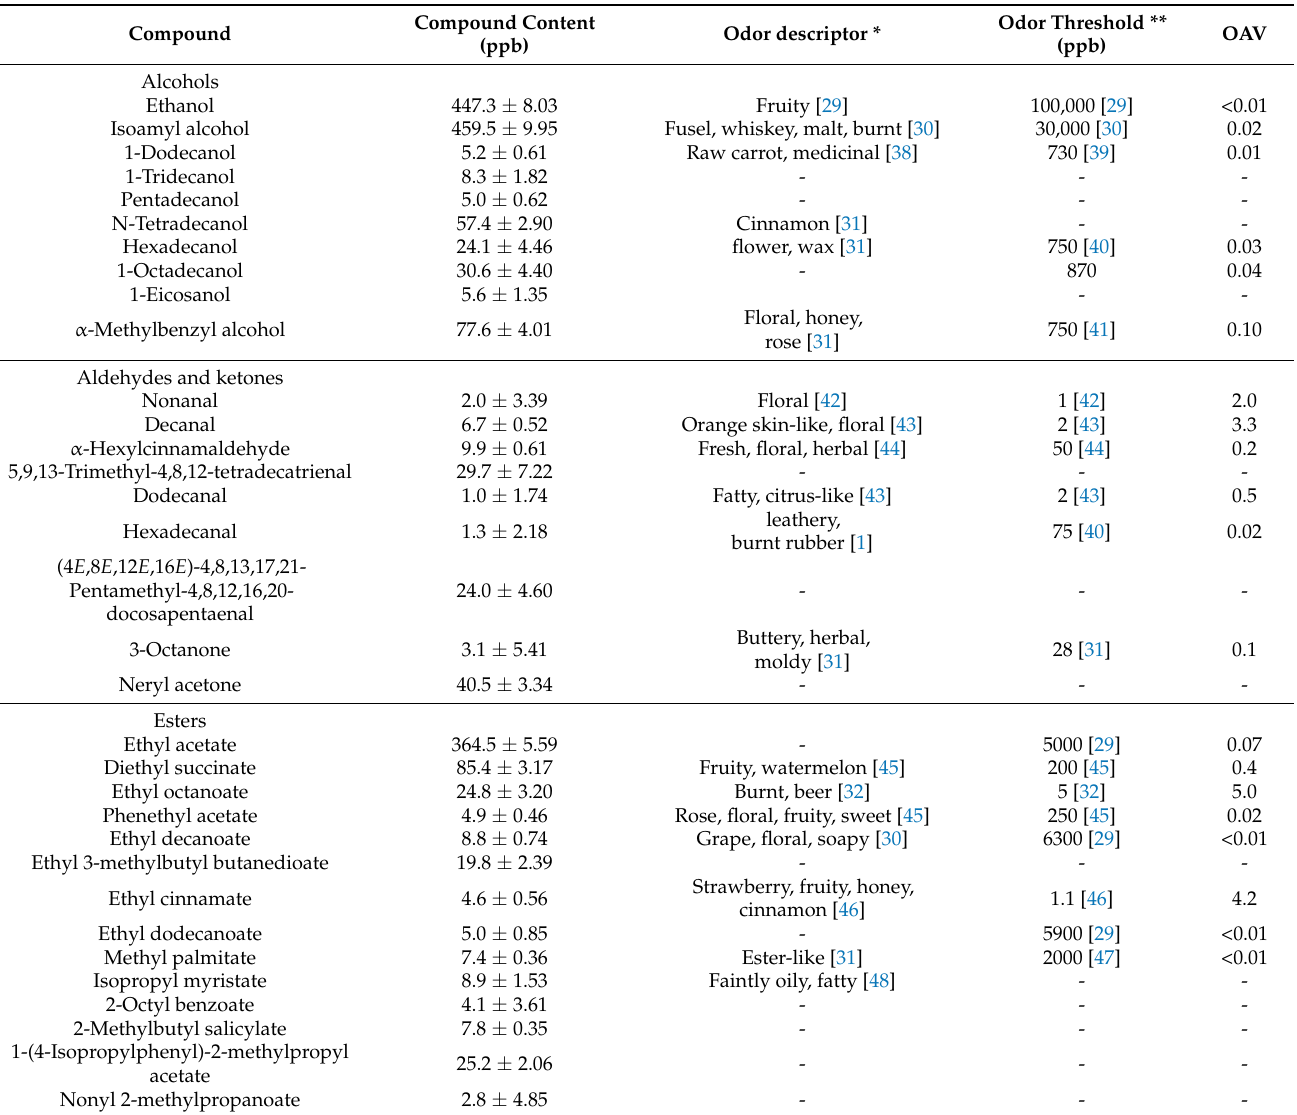
Table 1. Volatile organic compounds profile and odor features of jabuticaba wine. Odor descriptors, odor threshold, and odor activity value of jabuticaba wine extracted by SPME-CG/MS using PDMS- DVB